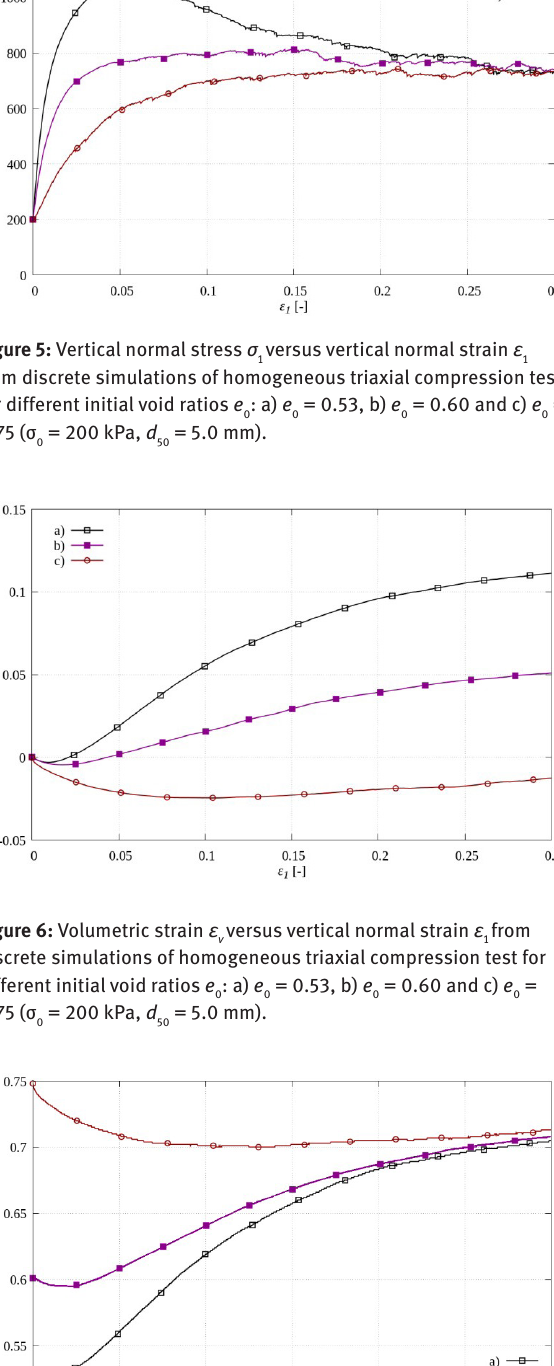
Table 1: Material micro-parameters for discrete simulations. Material micro-parameters